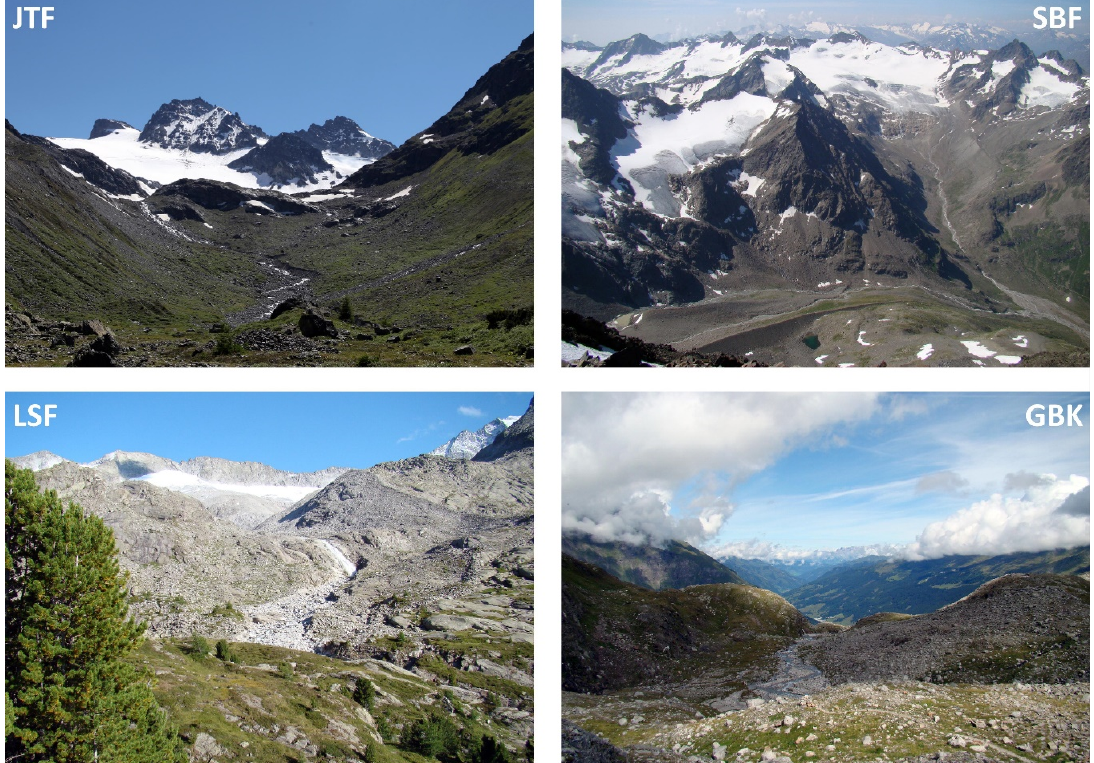
Figure 3. Aspects of the four glacier forelands studied. JTF: View from the LIA terminal moraine upstream to the glacier of JTF; SBF: “Aerial” view from Schrankogel (3496 m a.s.l.) into the glacier foreland of SBF coming from the left. LIA terminal moraine is located shortly after the confluence with the Sulz-Valley at the right side of the image; LSF: View into the lacier foreland from outside the LIA moraines, which are clearly visible to the right of the stream as prominent ridge; GBK: View from within the glacier foreland towards the LIA terminal moraine, which is in front of the little hill to the left of the center of the photograph. Table 1. Key figures for the environmental conditions and the chronosequences sampled within the four glacier forelands studied.